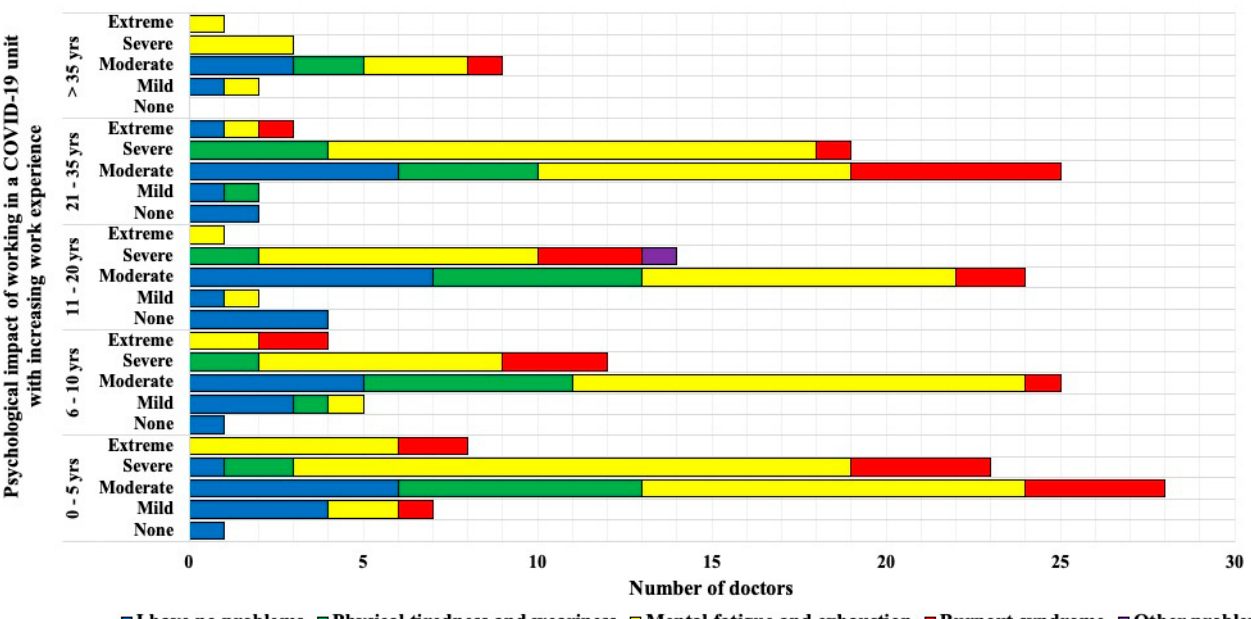
Figure 2. Comparison of psychological impact of working in a COVID-19 unit with increasing work experience and psychosomatic effect.